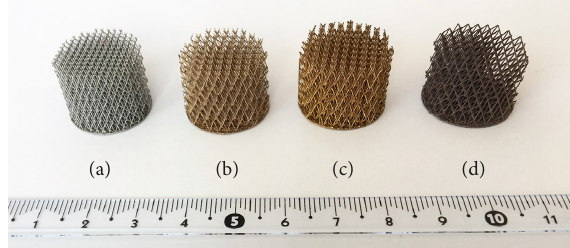
Figure 7: Digital photos of manufactured Ti6Al4V lattice (a) and heated and nitrided Ti6Al4V lattices at 750 ° C (b), 900 ° C (c), and 1050 ° C (d). Volume fraction and unit cell size are 6% and 2mm, respectively (diameter of lattice structures is 20 mm, and length is